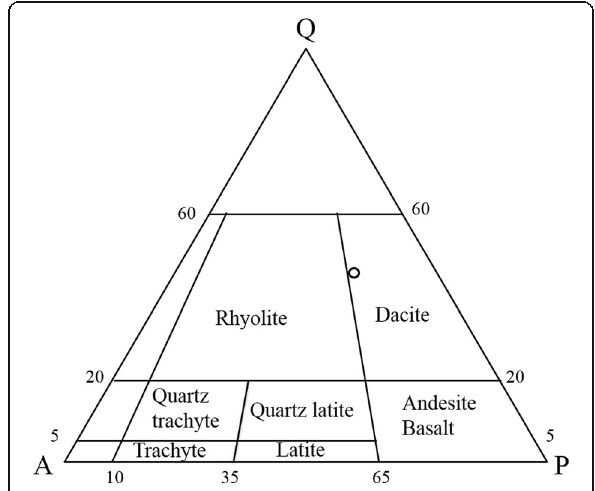
Fig. 7 IUGS Classification of volcanic rocks (Streckeisen 1979). White circle plot represents the silicic clast (this work)